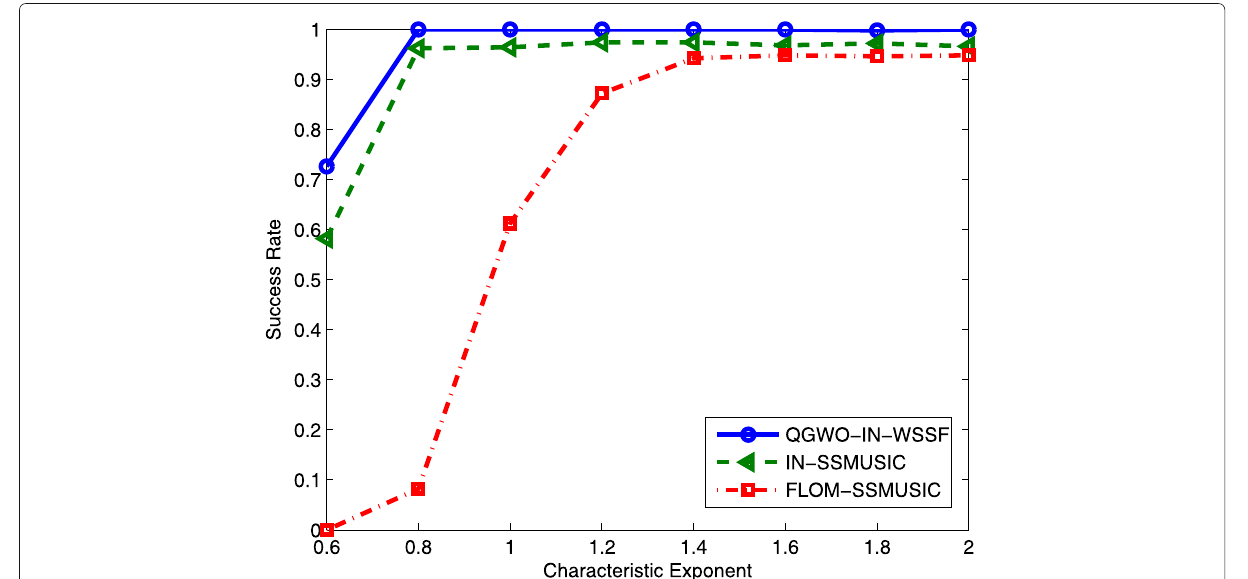
Fig. 11 Success rate curves versus characteristic exponent for two coherent sources with GSNR =